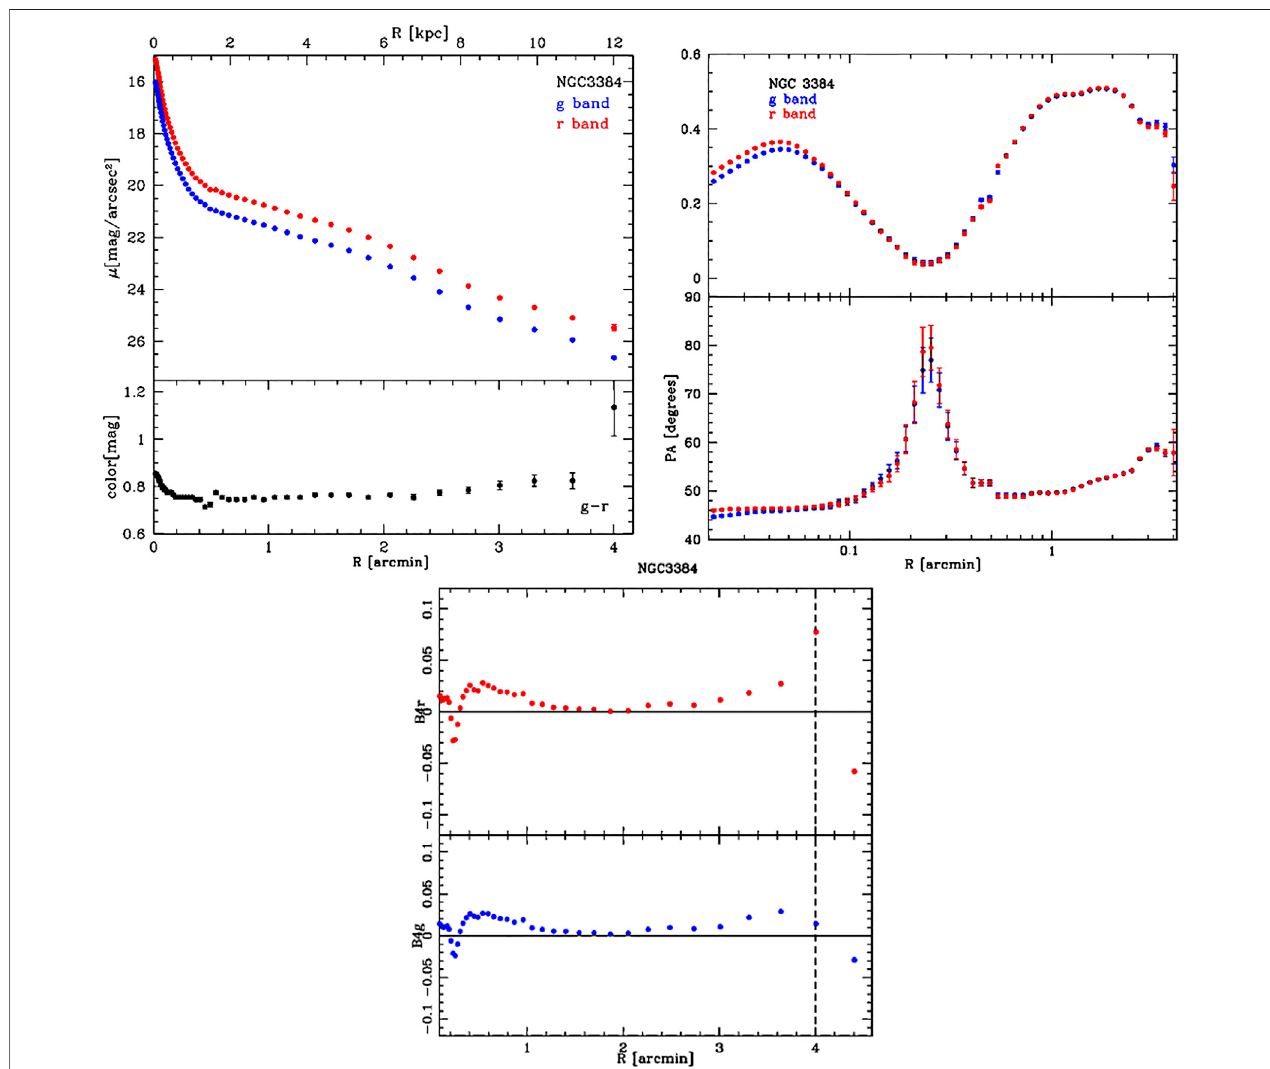
FIGURE4| Topleftpanels: azimuthally-averagedsurfacebrightnesspro fi lesofNGC3384inVST g (blue)and r (red)bands(toppanel)and g − r colorpro fi leofNGC 3384(bottompanel). Toprightpanels: azimuthally-averagedellipticity(toppanel)andpositionangle(bottompanel)pro fi lesofNGC3384inVST g (blue)and r (red)bands. Bottom panels: radial pro fi les the B4 Fourier coef fi cient as a function of semi-major axis in VST r (top panel) and g (bottom panel) bands for NGC 3384. In this case also the coef fi cient B4 gives an indication of the lack of a evident accreted component (see details in the text in Section 3.4).